Question: In a single sentence, describe what this figure presents.
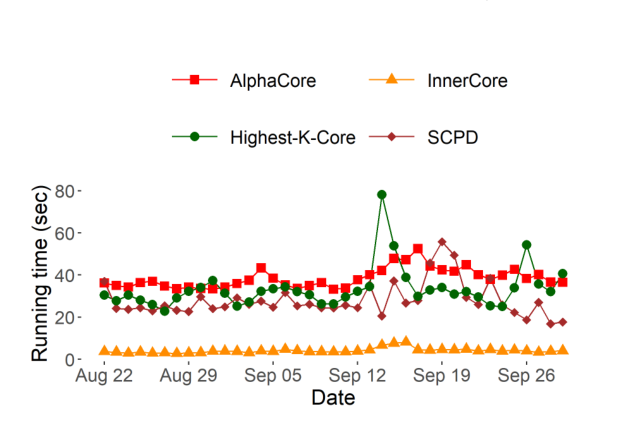
Answer: Comparison between running times of AlphaCore with the starting 𝜖= 1.0 and stepsize 𝑠= 0.1, InnerCore with 𝜖= 0.1 on daily Ethereum transaction networks to return the InnerCore of depth < 0.1. An average of approximately 480,000 nodes (addresses) and 1 million edges (transactions) exist in each network. The average computation time is 4.06 seconds (max 8.1s), which is approximately 0.10 times the average computation time of AlphaCore, 0.12 times the average computation time of the highest graph 𝑘-core, and 0.14 times the average computation time of SCPD.